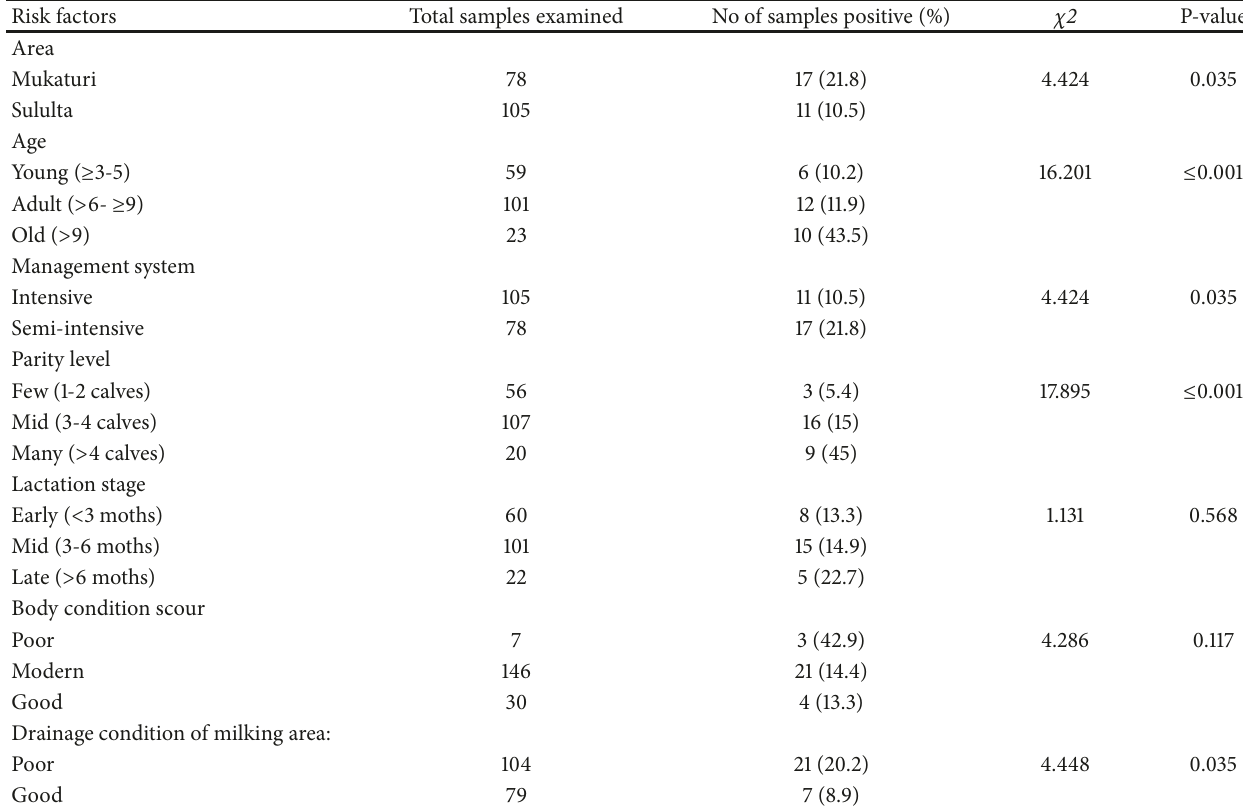
Table 5: Risk factors for prevalence of Staphylococcus aureus in milk.